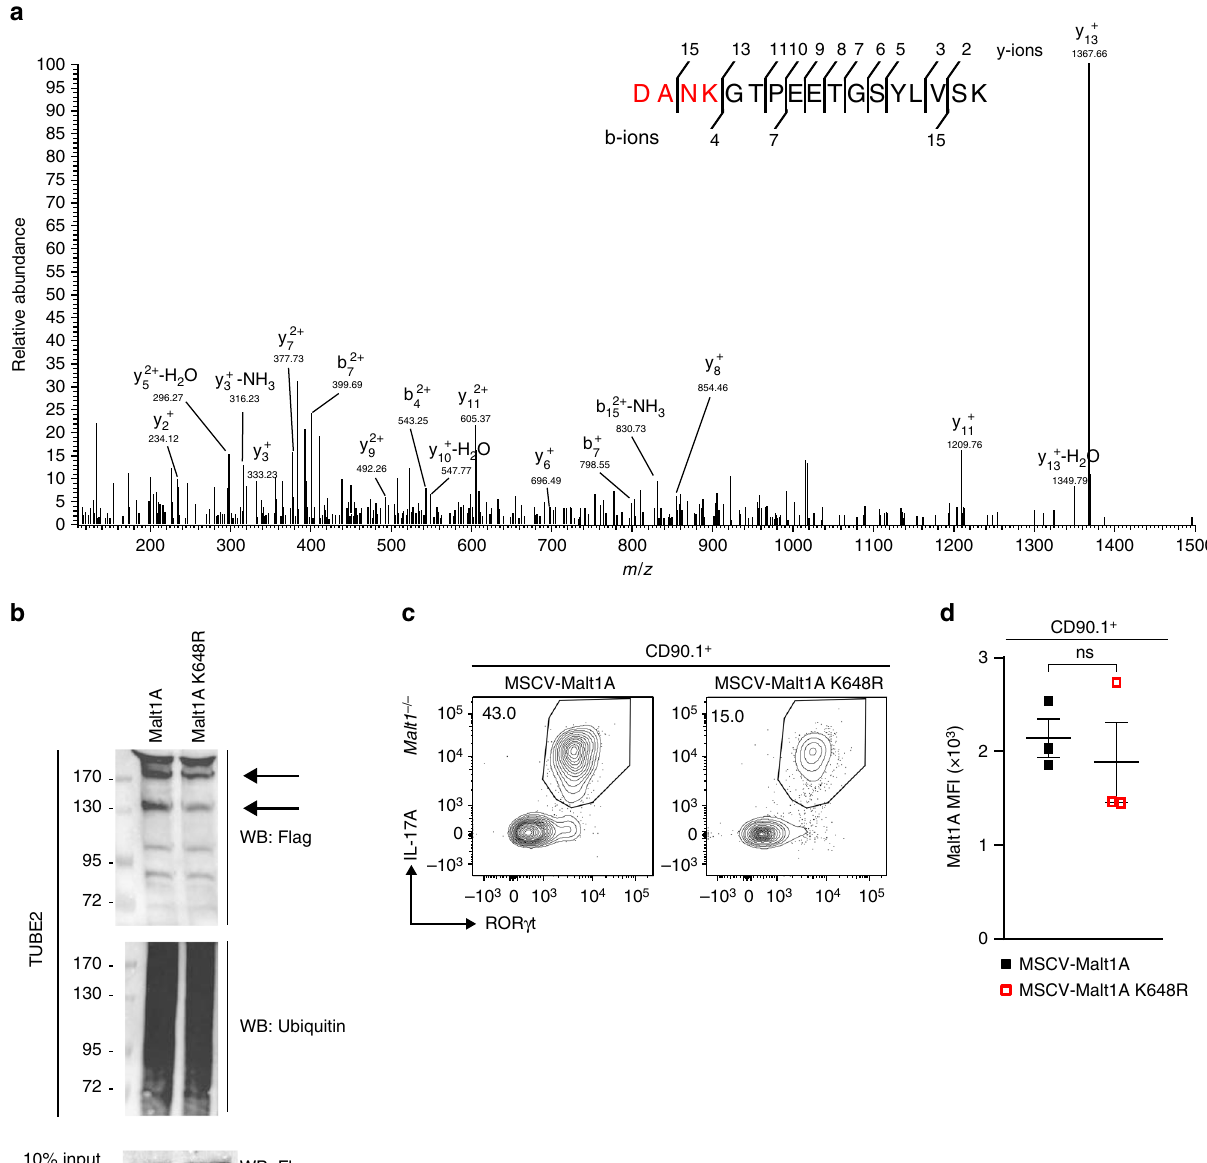
Fig. 6 Ubiquitination of Malt1A K648 by Hectd3 is essential for ROR γ t + IL-17A hi Th17 cell generation. a HEK293T cells were co-transfected with HA-Ub, Flag-Malt1A, and Xpress-Hectd3. Extracts were immunoprecipitated with anti-Flag antibodies, followed by trypsin digestion and tandem mass spectrometry, as described in Material and methods. A fragmentation spectrum of ubiquitinated DANKGTPEETGSYLVSK peptide (ubiquitinated K648 residue) of Malt1A. Parent ion corresponding to DANkGTPEETGSYLVSK peptide mass has been subjected to higher-energy collisional dissociation in mass spectrometer. The detected b- and y-fragment ion series have been annotated. b Representative immunoblot of Flag and ubiquitin following polyubiquitinated protein enrichment of extracts using TUBE2 from CD90.1 + sorted EL4 cells transduced with MSCV-CD90.1-Flag-Malt1A or MSCV- CD90.1-Flag-Malt1A K648R retrovirus. c Flow cytometry analysis of intracellular IL-17A and intranuclear ROR γ t in CD90.1 + Malt1 − / − CD4 + T cells transduced with indicated retrovirus and in vitro polarized under Th17 conditions. Representative of three independent experiments. Gating strategy was fi rst on CD90.1 + T cells. d MFI of Malt1A in CD90.1 + Malt1 − / − CD4 + T cells transduced with indicated retroviruses and in vitro polarized under Th17 condition. Data ( n = 6) are mean of three independent experiments and are presented as mean ± SEM; p value was obtained from Student ’ s t test. Source data are provided as a Source Data fi